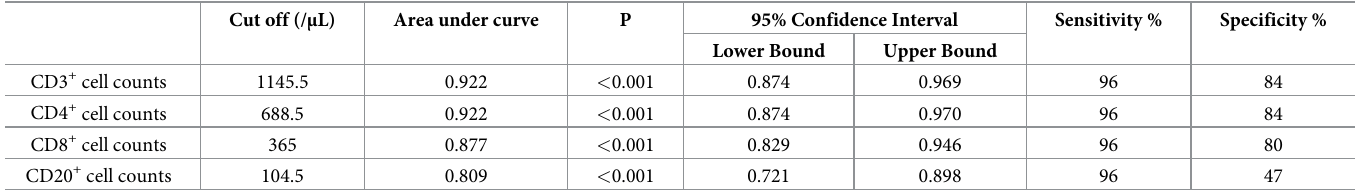
Table 6. Determination of lymphocyte cut-offs to differentiate between patients with Covid 19 and healthy controls. Cut off (/ μ